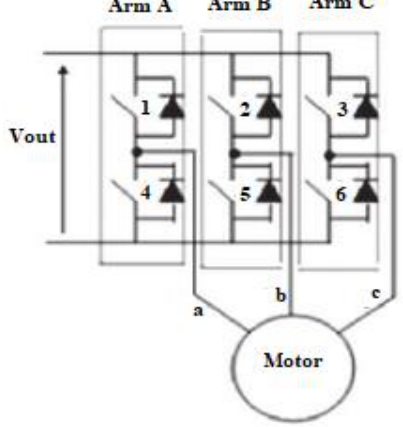
Figure 22. Schematic diagram of the inverter.